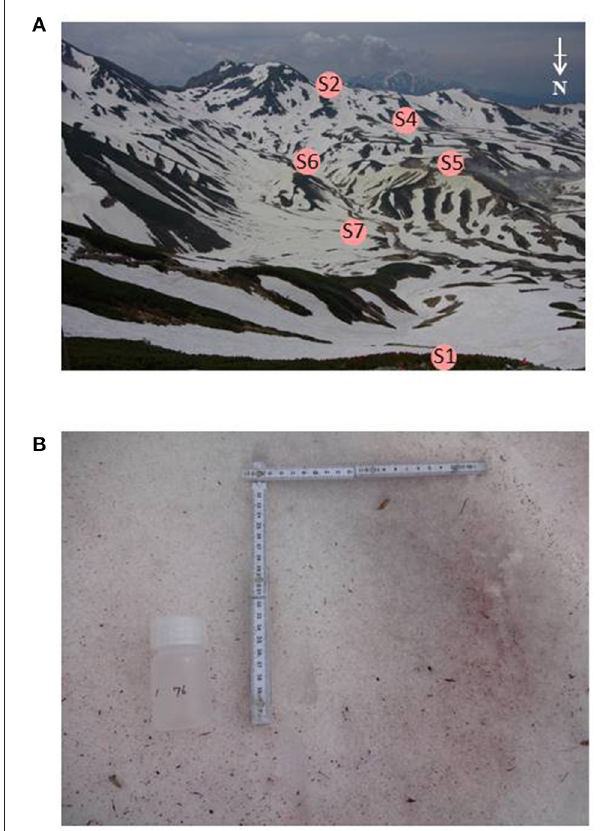
FIGURE 2 | (A) Photographs of the study area, Murodo-Daira, alpine plateau, Mt. Tateyama. The site S3 is not visible from this shooting point. (B) Red snow surface at the site S6 observed in June